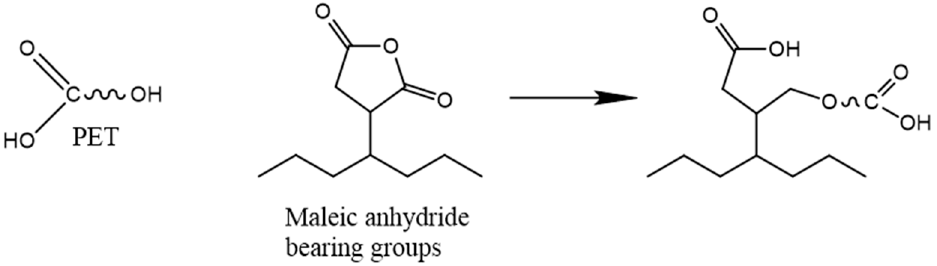
Figure 17. Chemical reaction between rPET and MA function of the compatibilizer Reproduced under terms of the CC-BY license with permission [335].